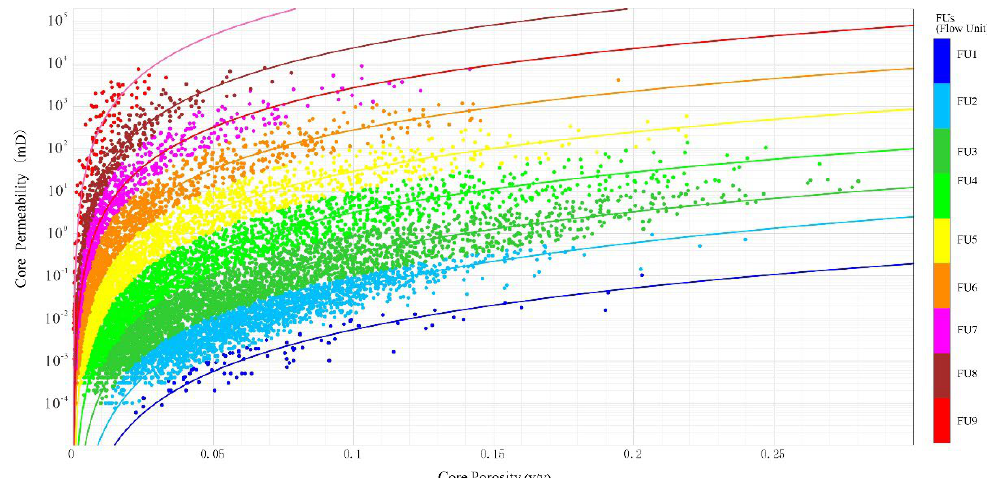
Figure 5. Porosity − permeability cross plots of different flow units.